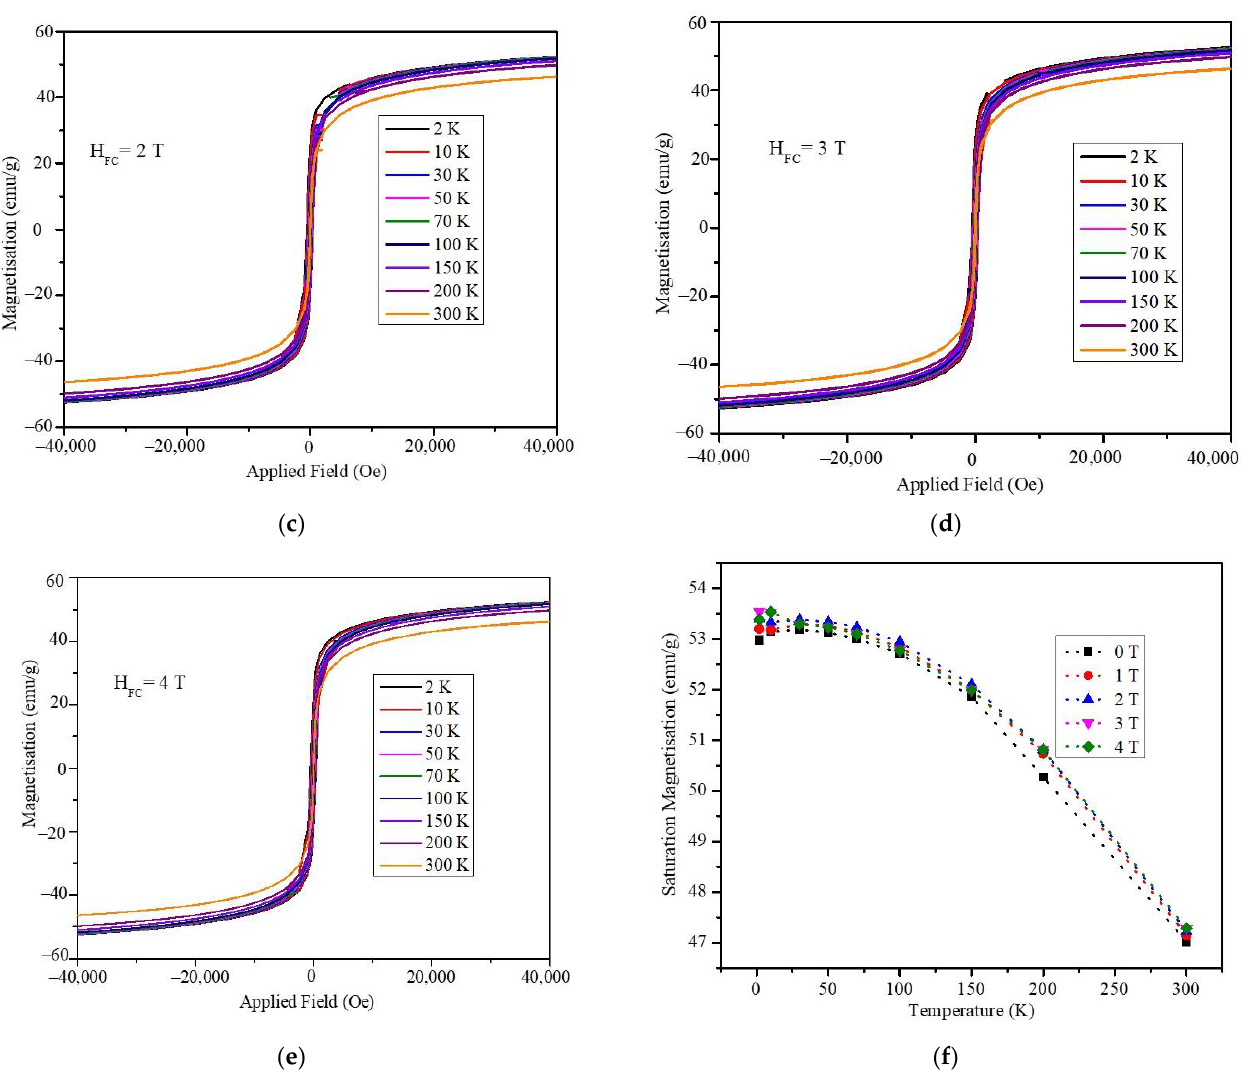
Figure 2. MH plots of the nanoparticles obtained under field cooling of ( a – e ) 0, 1, 2, 3, and 4 T. ( f ) Temperature-dependent saturation magnetization of maghemite nanoparticles under FC (0 – 4 T). The nanoparticles were cooled to 2 K in a zero magnetic field before being exposed to a tiny field of 70, 100, or 200 Oe to record the ZFC‑FC magnetization measurements. To obtain the ZFC magnetization curves, the sample was heated from 2 to 400 K while the magnetization was being measured. A magnetic field of 70, 100, or 200 Oe was applied while the particles were cooled from 400 to 2 K, and the magnetization was measured as a function of temperature to produce the FC magnetization curves. Figure 3 displays the FC and ZFC plots that were produced for the maghemite nanoparticles. The blocking tem‑ perature of the maghemite nanoparticles is indicated by the arrow in each ZFC plot. The blocking temperature measured shows a dependency on the applied magnetic field used for obtaining the MT measurements as evident from the plots at 200 Oe; the blocking tem‑ perature is 187.5 K, whereas at 70 and 100 Oe, it is around 217.5 K. The broadening of the peak region in the ZFC plots indicates that the nanoparticles possess significant size dis‑ tribution. The shift in the blocking temperature with respect to the magnetic field applied can be attributed to the dipolar interaction of the nanoparticles [23]. The magnetization in the FC plot increases monotonically with the decrease in the temperature down to 50 K, below which it flattens. This flattening nature of the FC curve below 50 K after bifurcation hints at the existence of surface spin freezing at low temperatures